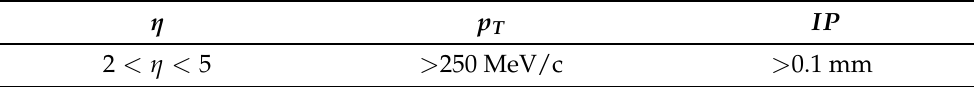
Table 3. List of cuts applied to charged particles entering the computation of the isolation. See text for